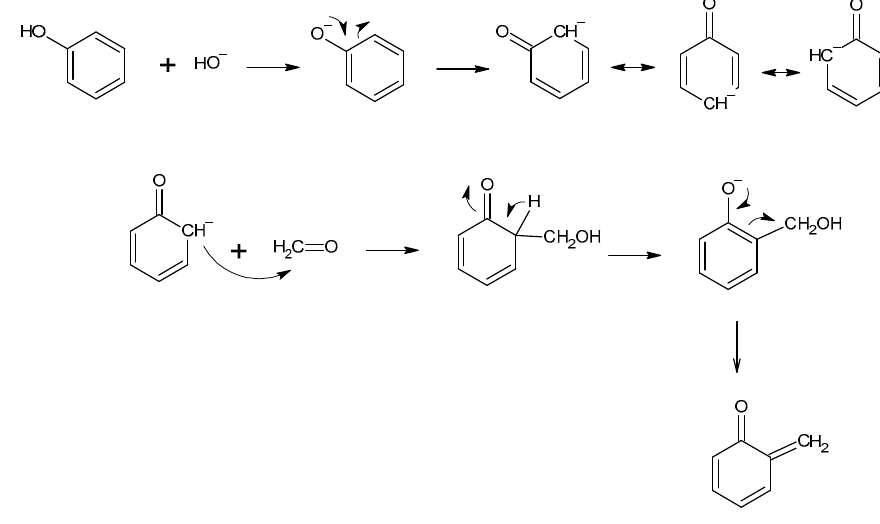
Figure 3. Reaction between melamine and formaldehyde.